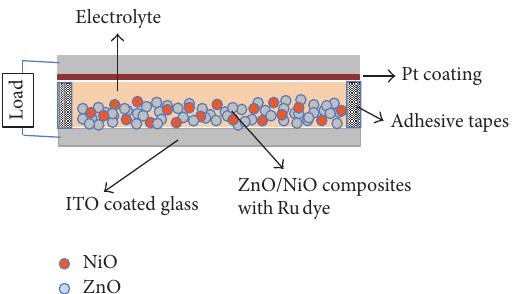
Figure 1: Schematic diagram of the DSSC based on ZnO/NiO nanocomposite particles.